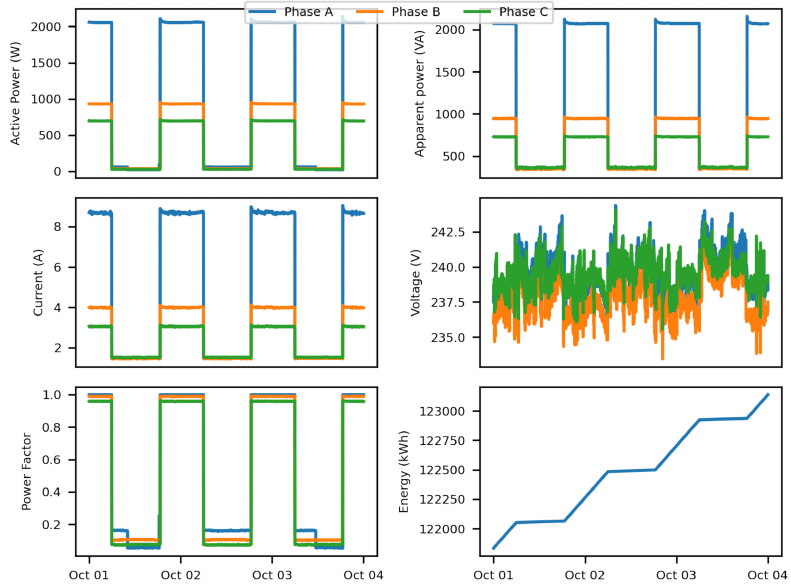
Figure 2. Example of smart meter